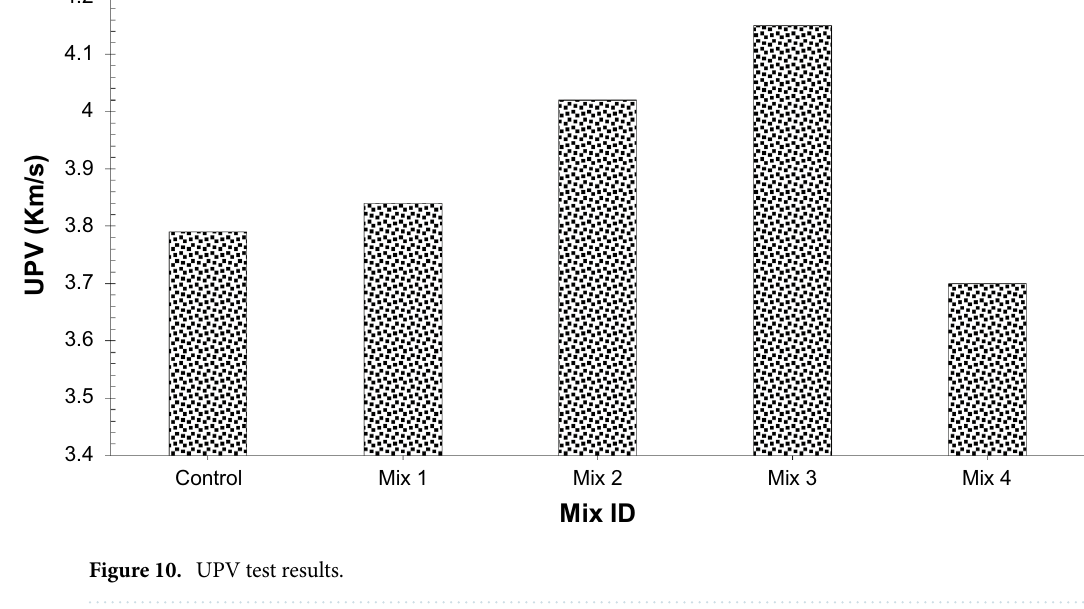
Figure 10. UPV test results.